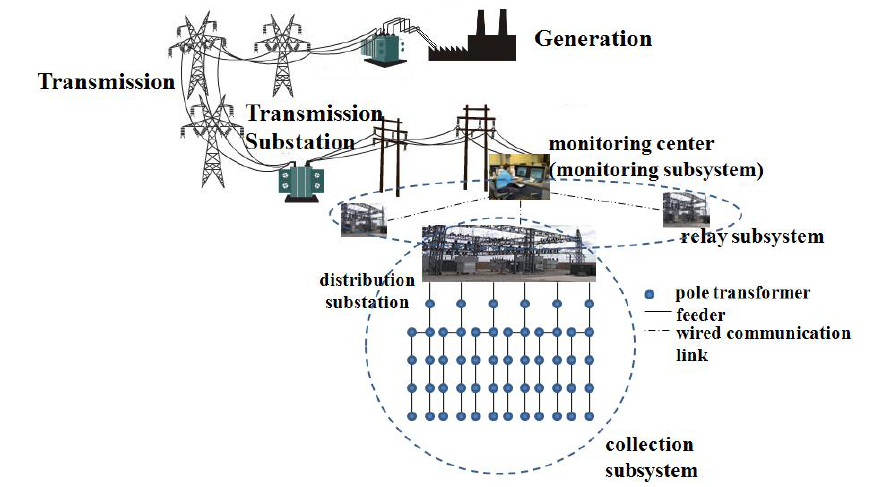
Figure 1. Network infrastructure for EV